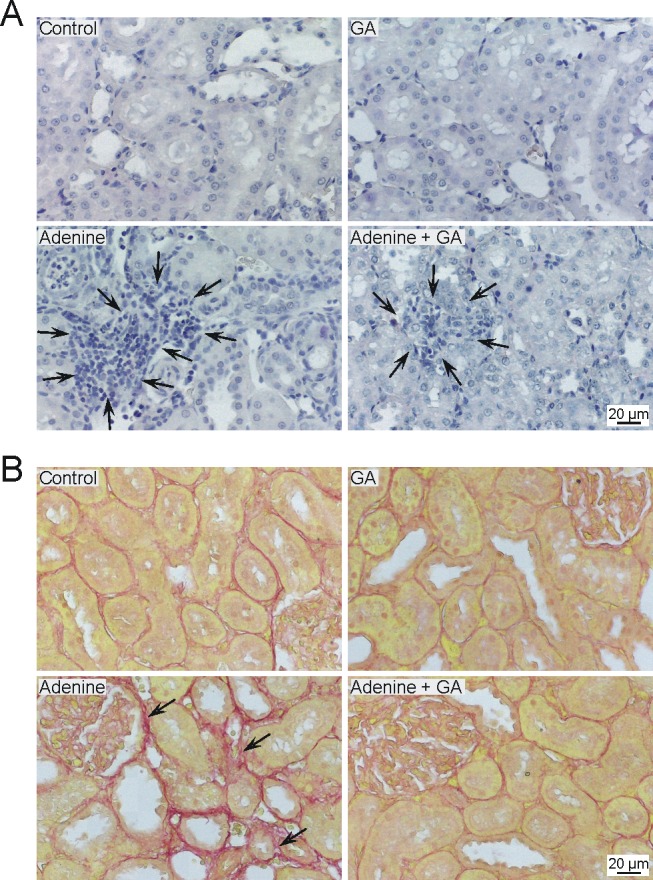
Occurrence of inflammation (A) in kidneys of control rats, rats treated with gum arabic (15% w/v in drinking water) and rats treated with adenine (0.75% w/w) alone in feed, or with adenine and gum arabic given concomitantly at the same dose for 28 days.Black arrows in the representative pictures of tissue stained with hemytoxylin point to leucocyte infiltration. Occurrence of fibrosis (B) in the kidneys of control rats, rats treated with gum arabic (15% w/v in drinking water) and rats treated with adenine (0.75% w/w) alone in feed, or with adenine and gum arabic given concomitantly at the same dose for 28 days. Shown are representative pictures of fibrosis in the kidney, with black arrows pointing to examples of collagen disposition, visualized by Sirius Red staining.